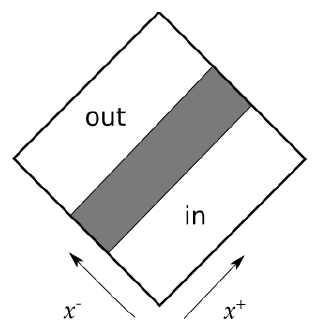
Figure 1 . The sandwich plane wave with x a -directions suppressed. The (cid:12)eld strength F a = _ A a ( x (cid:0) ) is non-zero only in the shaded region; the gauge (cid:12)eld is (cid:13)at on the in- and out-regions. The set of (2 d (cid:0) 3) symmetry generators f @